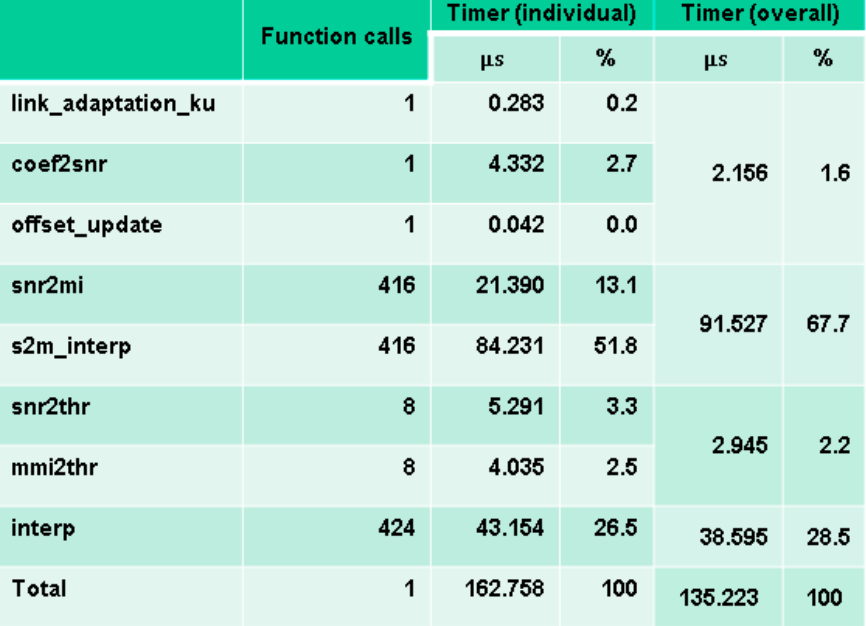
Figure 14. Execution time per packet for each function.